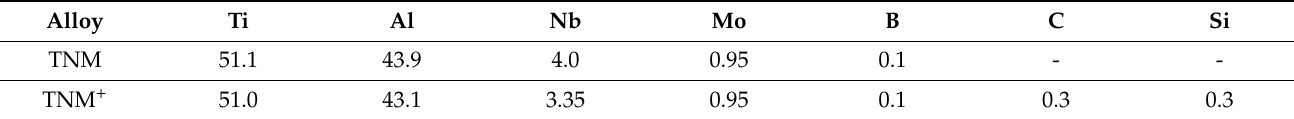
Table 1. Chemical analysis of the TNM and TNM + powder. The values are given in at.% and were determined using X-ray fluorescence spectroscopy, inductively coupled plasma optical emission spectroscopy and carrier hot gas